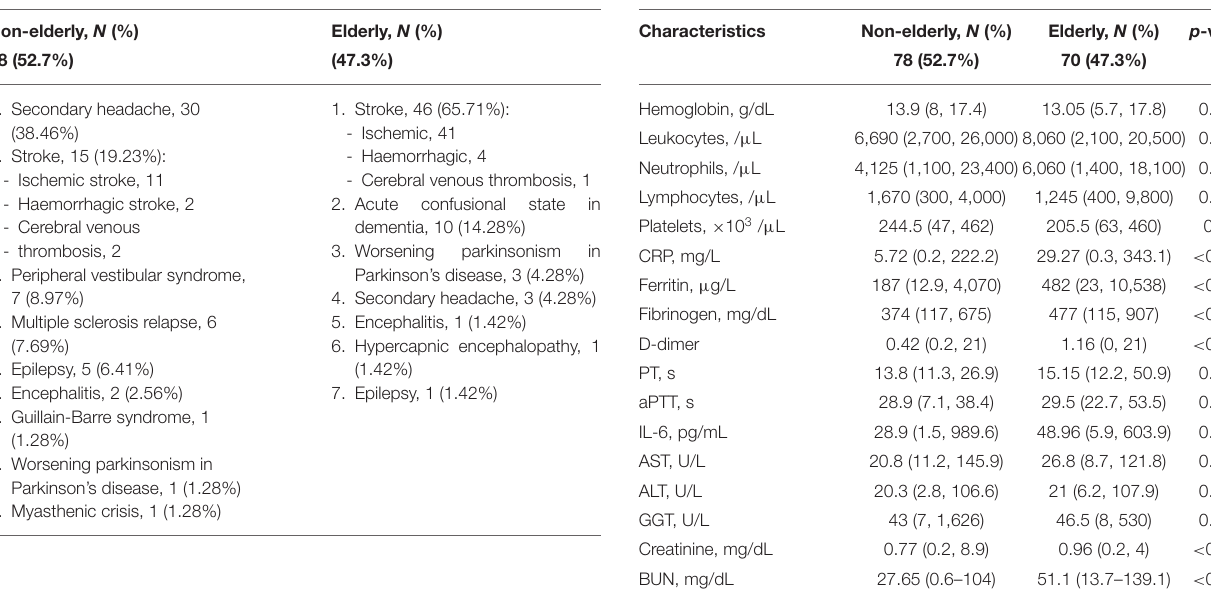
TABLE 3 | Paraclinical characteristics of